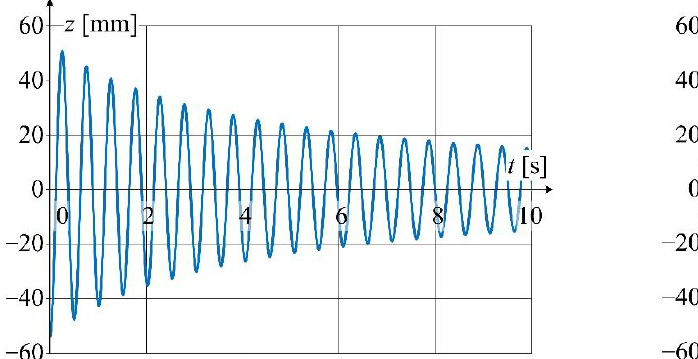
Figure 19. Displacement waveforms of simulation results at non-linear damping coefficient.